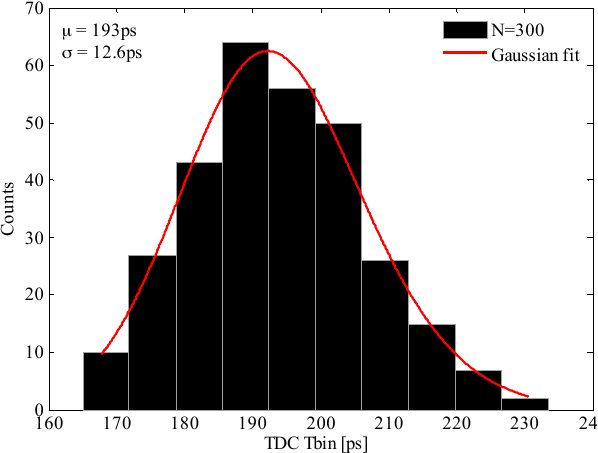
Figure 13. Simulated TDC T bin deviation due to the process parameters’ variation.